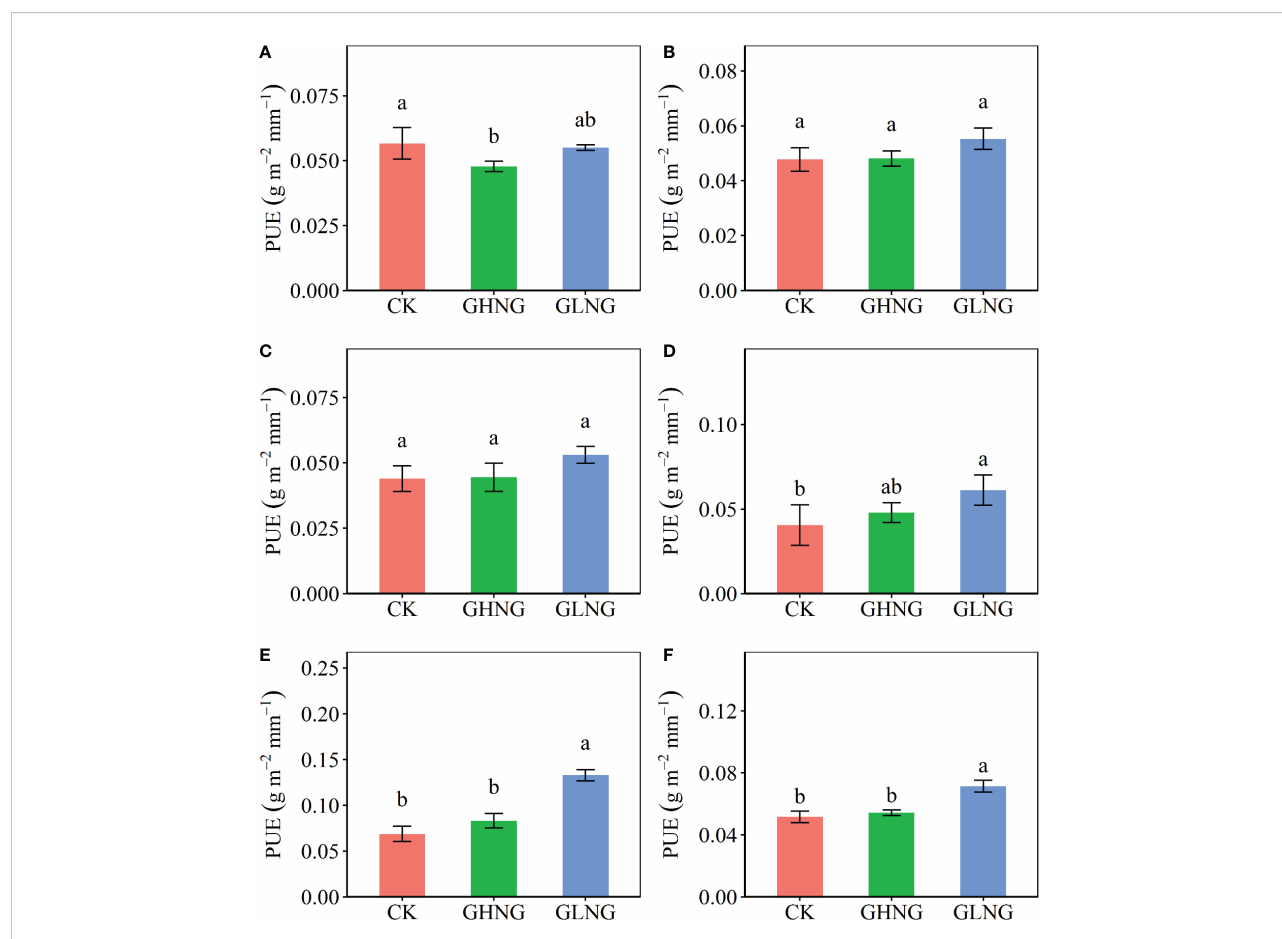
FIGURE 1 Comparison of precipitation use ef fi ciency (PUE) among the control (CK), warming level of growing-season higher than warming level of non-growing- season treatment (GHNG) and warming level of growing-season lower than warming level of non-growing-season treatment (GLNG) in (A) 2015, (B) 2016, (C) 2017, (D) 2018, (E) 2019 and (F) 2015 – 2019, respectively. Different letters indicate signi fi cant differences among the three treatments at p <0.05 level.